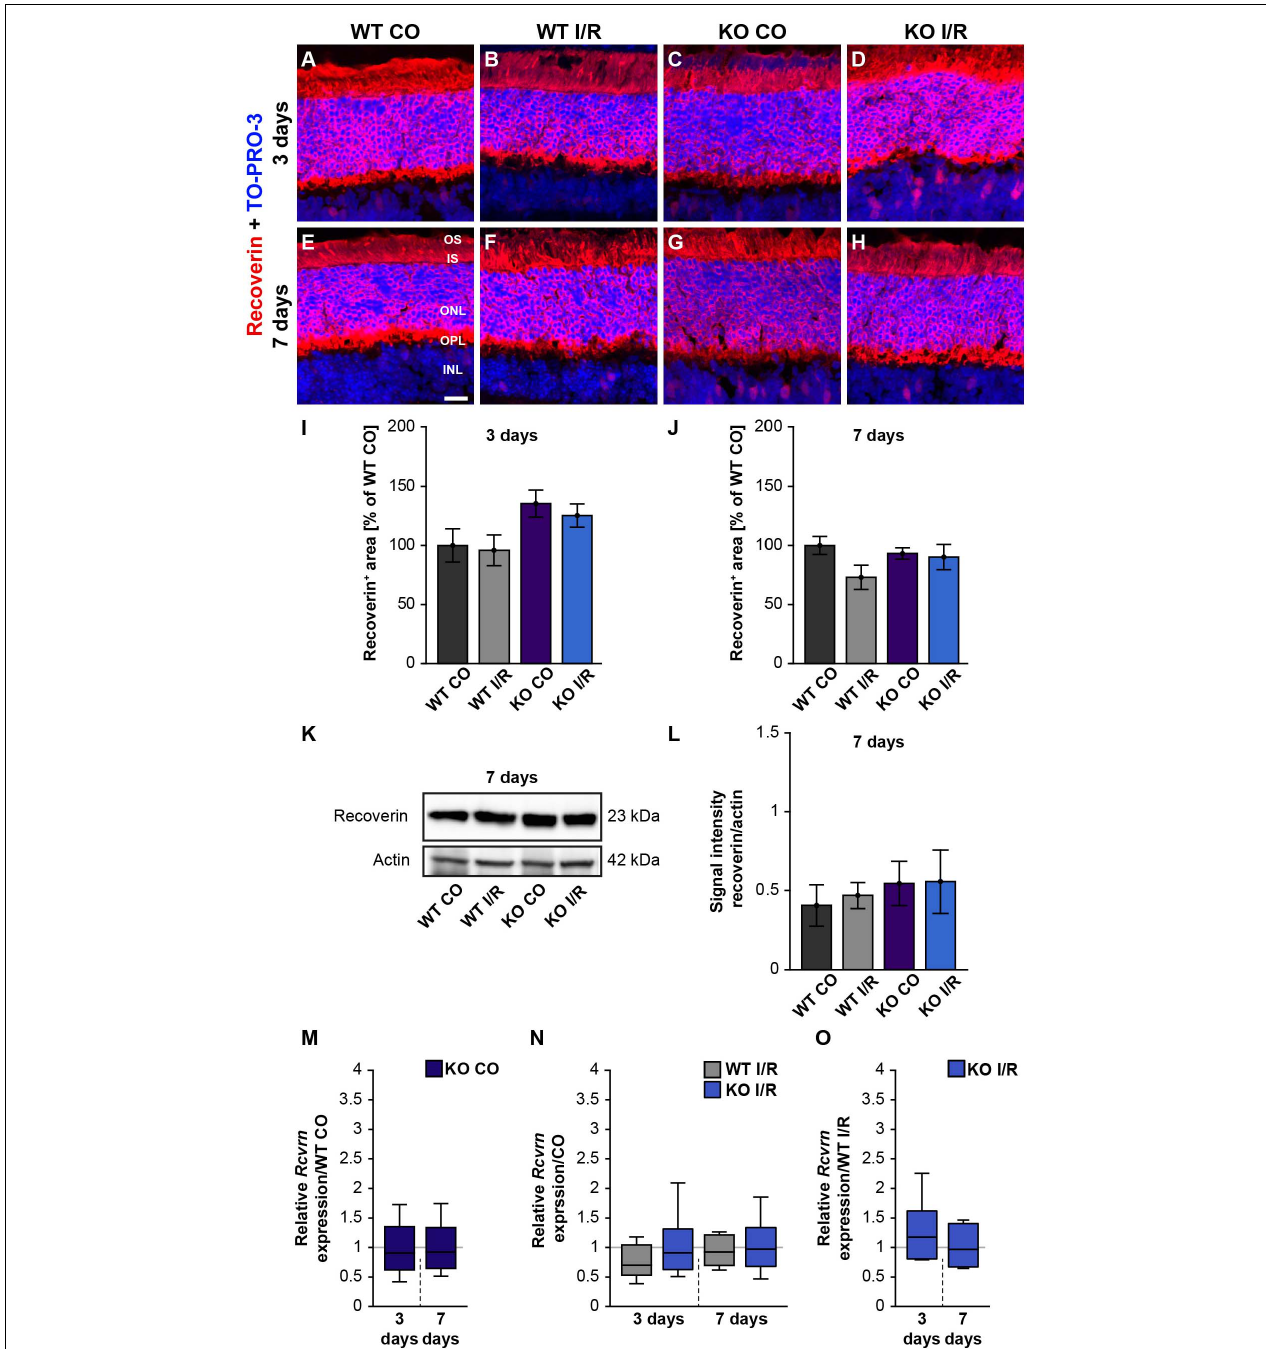
FIGURE 5 | Unaltered recoverin levels in WT and KO mice after ischemia. (A–H) Photoreceptors cells were marked with an antibody against recoverin (red) and cell nuclei were labeled with TO-PRO-3 (blue) at 3 and 7 days post-I/R. (I,J) Recoverin + staining area was similar in the control and ischemic WT and KO groups at both analyzed points in time. The WT CO group was set to 100%. (K) Exemplary Western blots of recoverin at 7 days post-I/R. (L) No changes in the recoverin band intensity were observed in both genotypes. (M) A comparable Rcvrn expression was seen in the non-ischemic WT and KO groups at 3 as well as 7 days post-I/R. (N) An equal mRNA level of Rcvrn was detected in the ischemic groups when compared to the corresponding control groups. (O) In comparison to the WT I/R group, we also observed an unaltered Rcvrn expression in the KO I/R group. Groups were analyzed using two-way ANOVA followed by Tukey’s post hoc test. Data are shown as mean ± SEM in panels (I,J,L) . For RT-qPCR analyses, groups were compared using the pairwise fixed reallocation and randomization test. Data are shown as median ± quartile ± minimum/maximum in panels (M–O) . p > 0.05. n = 4–5/group. Scale bar = 20 µ m. OS: outer segments; IS: inner segments; ONL: outer nuclear layer; OPL: outer plexiform layer; INL: inner nuclear